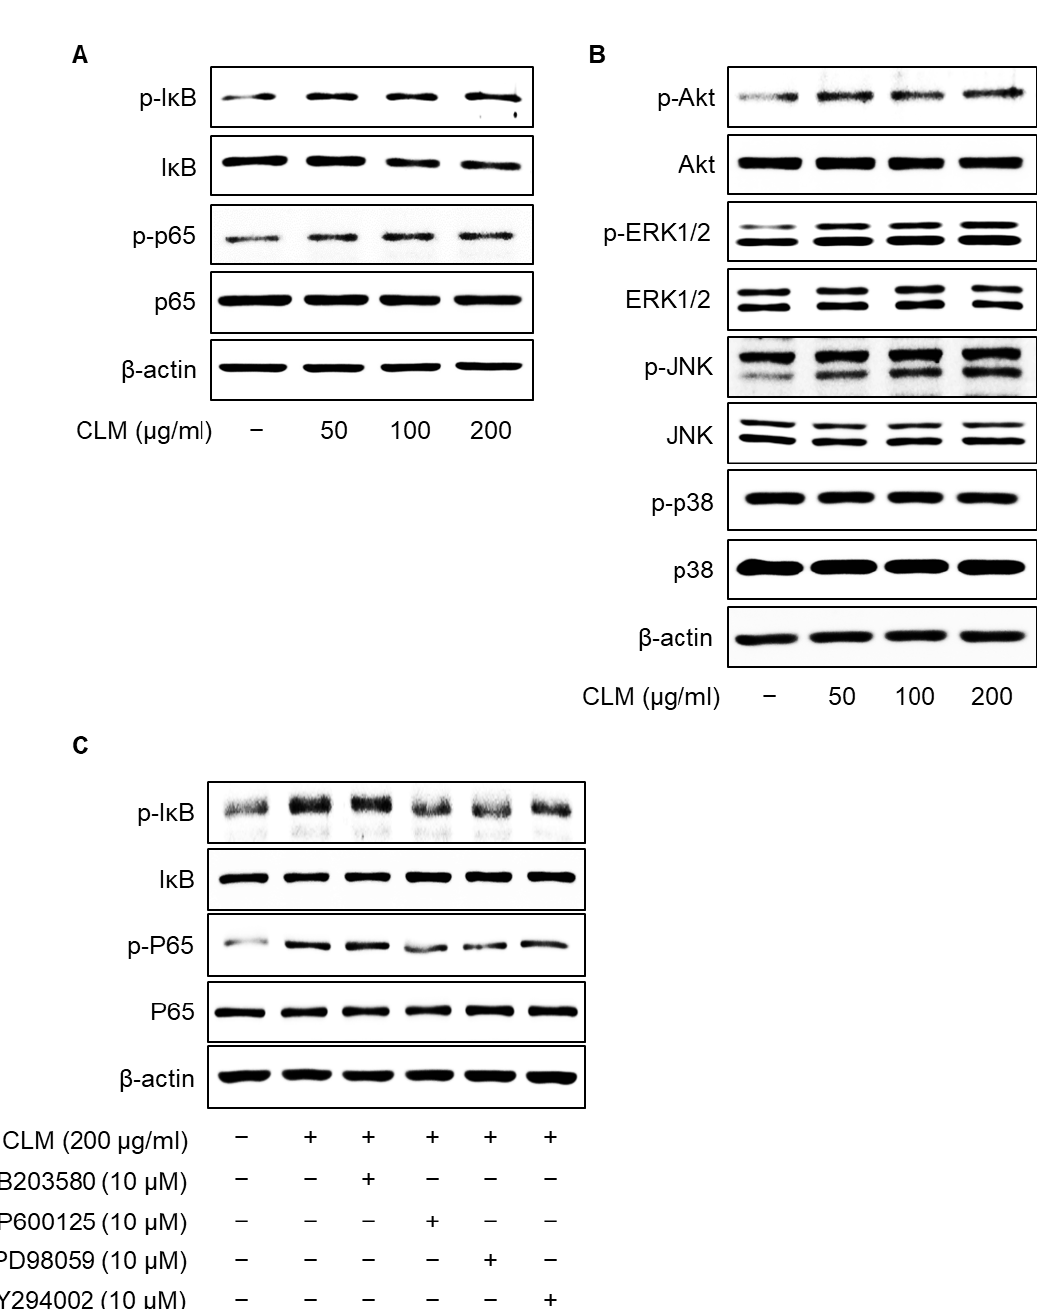
Figure 7. Effects of CLM-mediated NF- κ B, MAPK, and PI3K/Akt activation in macrophages. ( A , B ) RAW264.7 cells were seeded in a 6-well plate at a density of 2 × 10 5 cells/mL for 24 h, cultured at 37 ◦ C and 5% CO 2 , and treated with CLM (50, 100, and 200 µ g/mL) or LPS (1 µ g/mL) for 1 h. The phosphorylation of I κ B, NF- κ B, Akt, ERK1/2, JNK1/2, and p38 was analyzed by western blotting. ( C ) Effects of PI3K and MAPK inhibitors on CLM-induced NF- κ B activation. Cells were preincubated with 10 µ M LY294002, 10 µ M PD98059, 10 µ M SB203580, or 10 µ M SP600125 for 30 min, followed by incubation with 200 µ g/mL CLM for 1 h. Cell lysates were subjected to western blotting with p-I κ B, p-NF- κ B, I κ B, NF- κ B, and β -actin antibodies; β -actin was used as the loading control.